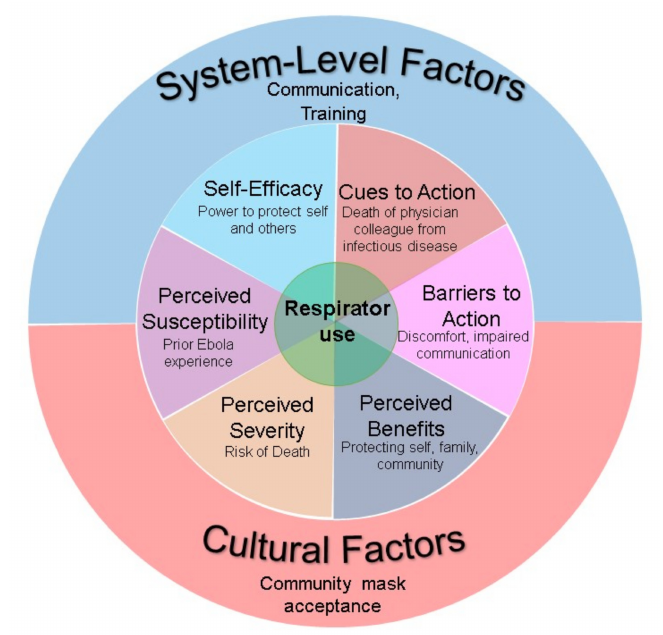
Figure 2. Framework including the Health Belief Model applied to health worker perspectives about respirator